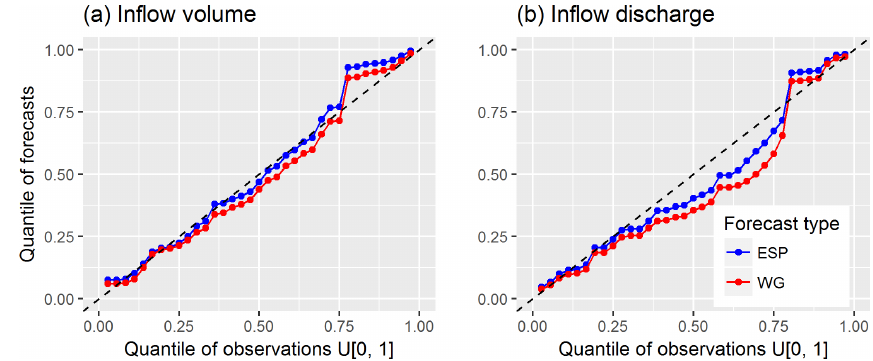
Figure 10. Predictive quantile–quantile plots for inflow volume (a) and inflow discharge (b)